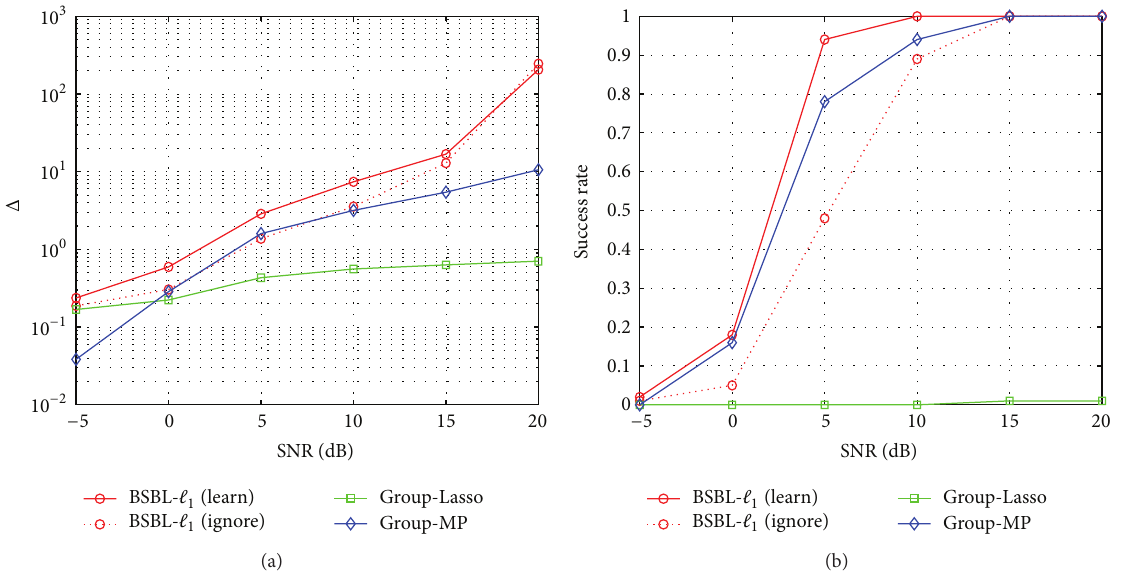
Figure 4: Comparison of metrics versus SNR. Grid distance is 10m. (a) Δ ; (b) success rate.